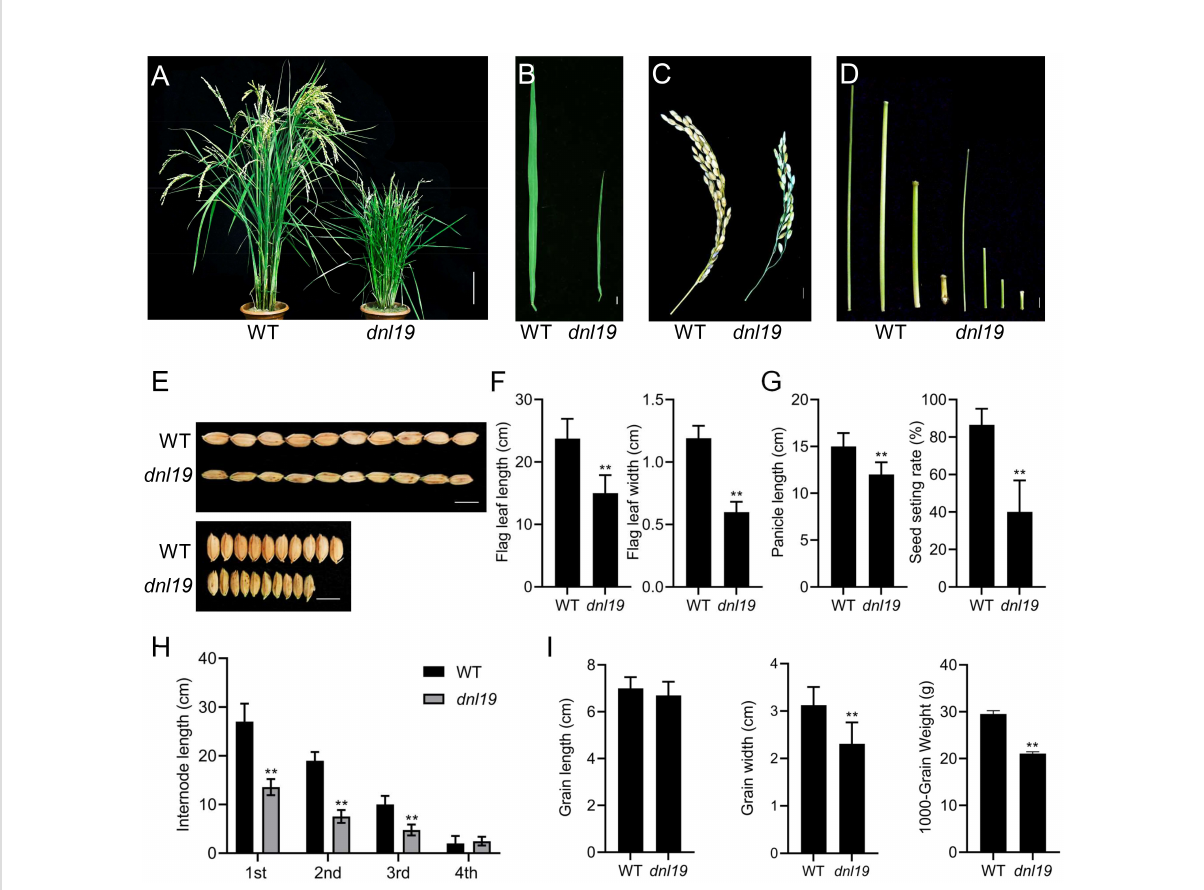
FIGURE 1 Characteristics of dnl19 mutant. (A) Dwar fi sm was observed in dnl19 plants at mature stage. Bar = 10 cm. (B) Flag leave of dnl19 was slenderer than that of wild type (WT). Bar = 1 cm. (C) Panicle morphology was affected in dnl19 . Bar = 1 cm. (D) The culm of dnl19 was shorter than that of WT. Bar = 1 cm. (E) The grain shape was affected in dnl19 plants. Bar = 1 cm. (F) Both the fl ag leaf length and width were reduced in dnl19 mutant. Data are means ± SD ( n ≥ 13, ** P < 0.01, Student ’ s t -test). (G) The dnl19 plants displayed a decrease in panicle length and seed setting rate. Data are means ± SD ( n ≥ 10, ** P < 0.01, Student ’ s t -test). (H) The 1st, 2nd and 3rd internodes of dnl19 were shortened. Data are means ± SD ( n ≥ 29, ** P < 0.01, Student ’ s t -test). (I) Grain length, grain width and 1000-grain weight of WT and dnl19 plants were statistically analyzed. Data are means ± SD (** P < 0.01, Student ’ s t